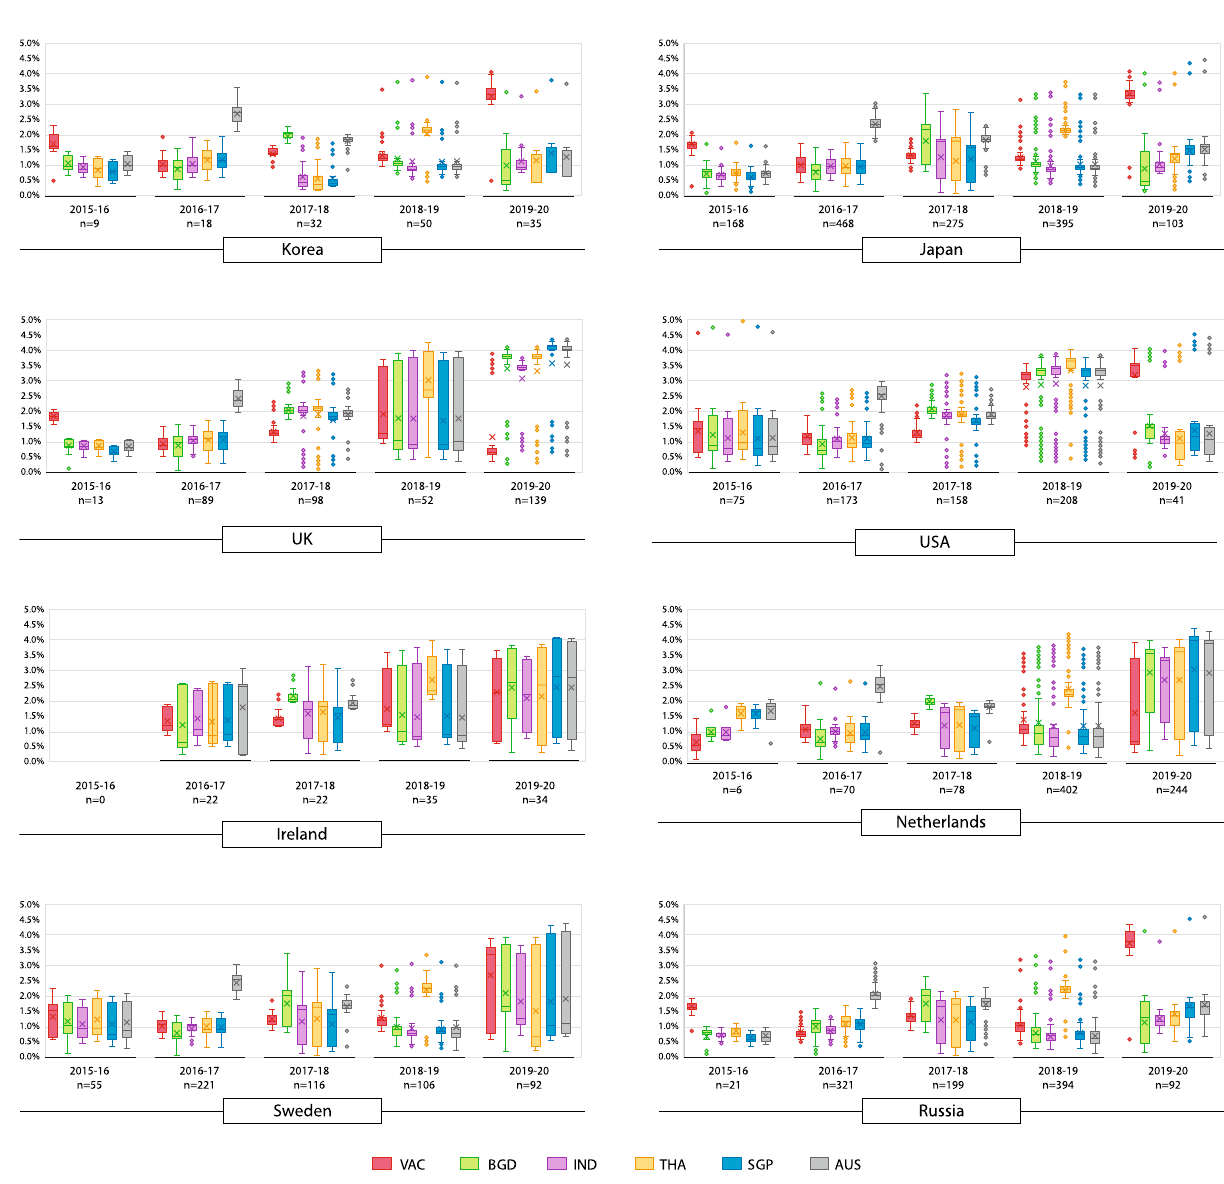
Figure 2. Genetic proximity of selected potential vaccine (p-vac) and WHO-recommended vaccine strain with circulating strains from consecutive seasons. Mean genetic distance (p-distance) of vaccine and p-vac strains in each season are shown separately as Box-plot graph. The number of analyzed sequences from a season were denoted with